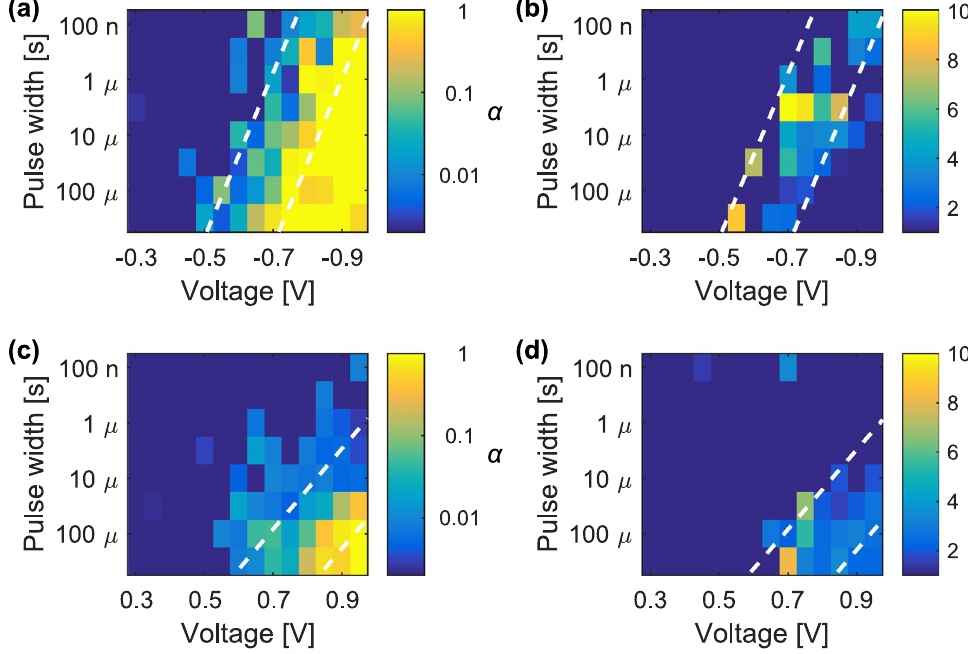
Figure 4. α and γ parameters extracted from fit to data of a generalized soft bound law as a function of Δ t and Δ V . ( a , b ) Refer to potentiation operations, while ( c , d ) refer to depression. In each figure, the dashed lines serve as visual distinction of the three switching regions: no switching (left), analogue (centre) and digital (right)